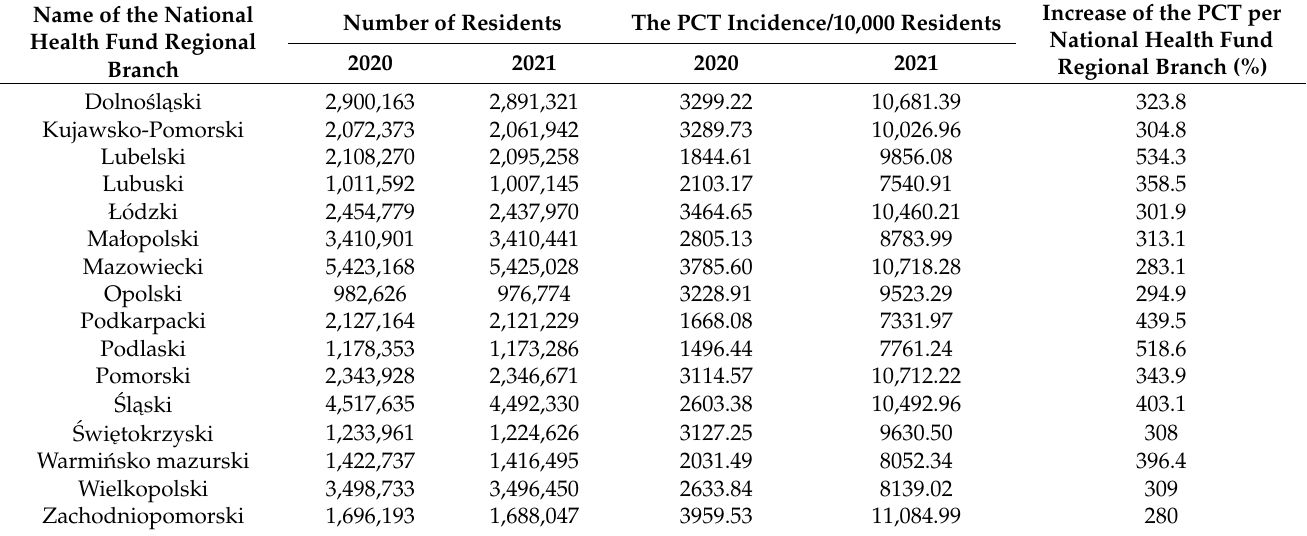
Table 1. The summary table of the number of residents of voivodeships and the incidence of PCT per 10,000